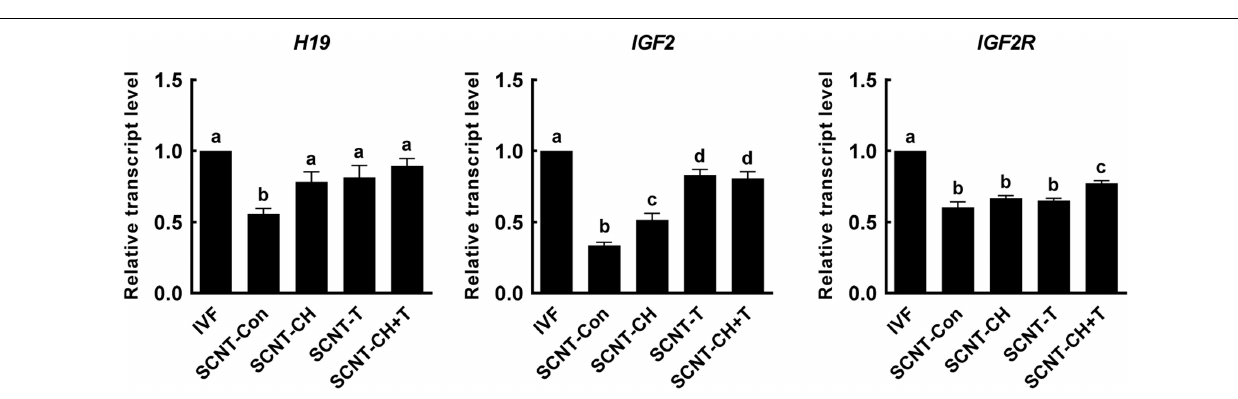
FIGURE 7 | Effects of chaetocin, TSA, and the combination on the genomic imprinting in porcine SCNT embryos. The data are from three independent experiments and are means ± SEM. Values with different superscripts differ significantly ( P < 0.05). IVF, in vitro fertilization; SCNT, somatic cell nuclear transfer; Con, control; CH, chaetocin; T,